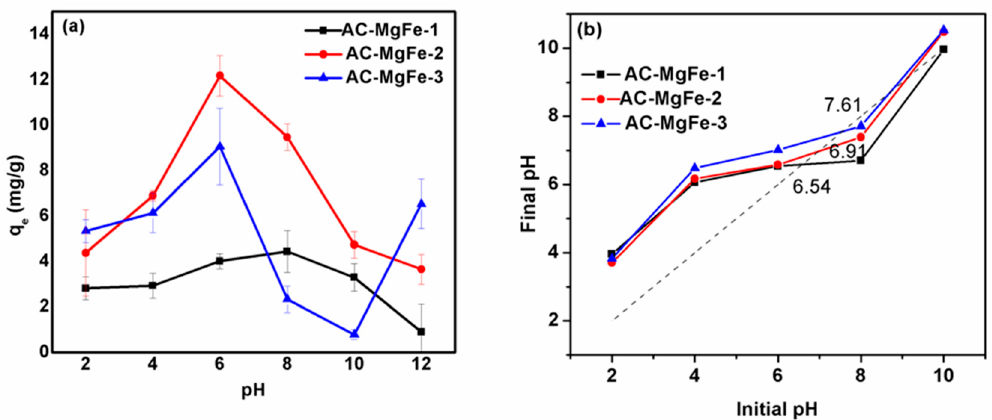
Figure 4. ( a ) Adsorption performance of phenol onto AC–MgFe composites at varied initial pH ( b )